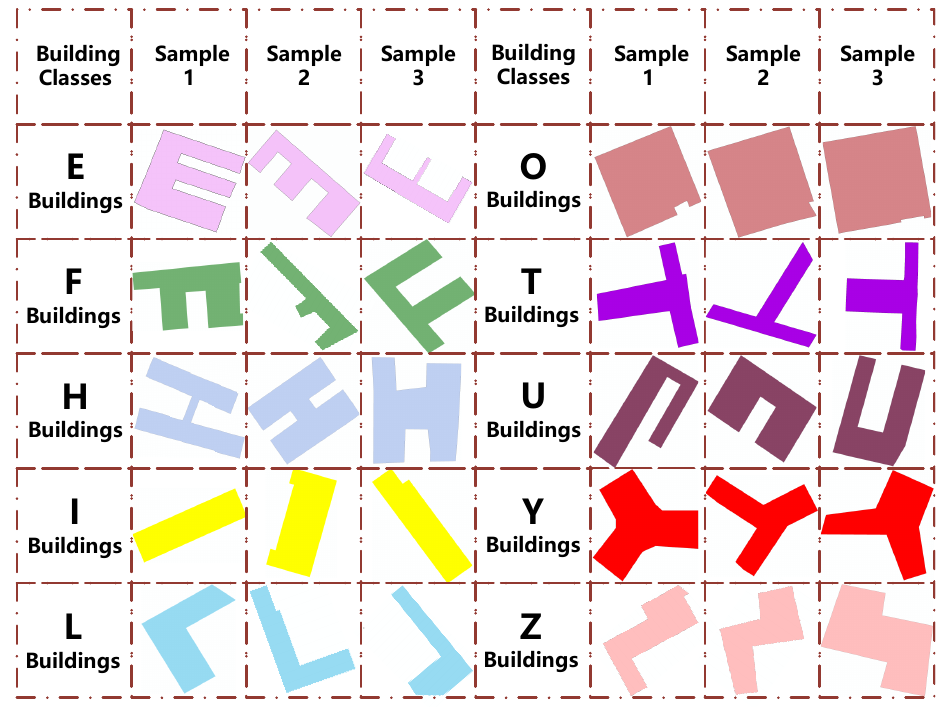
Figure 3. Raw data examples of 10 different classes of building footprints in the